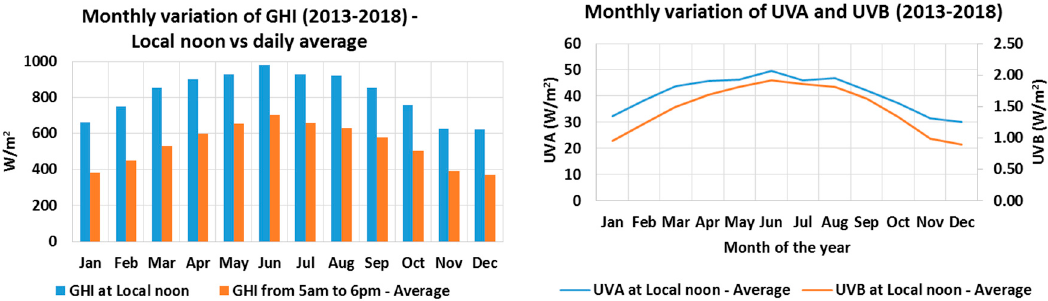
Figure 4. The monthly variation of ( left ) GHI at local noon and the intraday average, ( right ) UVA and UVB from 2013 to 2018 at the surface station in Doha, Qatar.